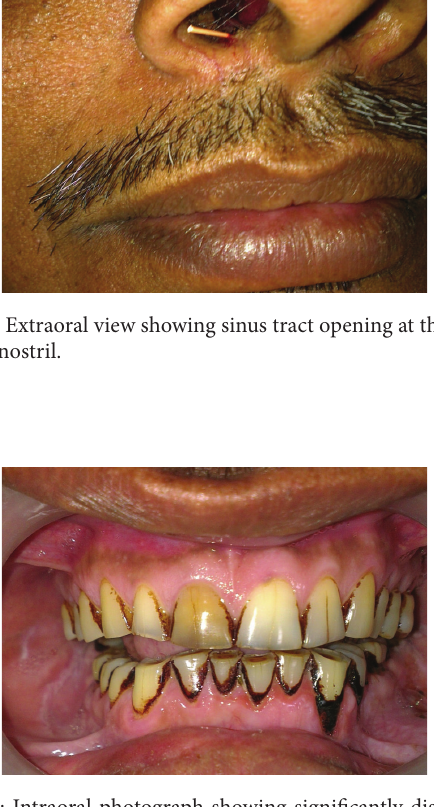
Figure 2: Intraoral photograph showing significantly discoloured maxillary right central incisor.